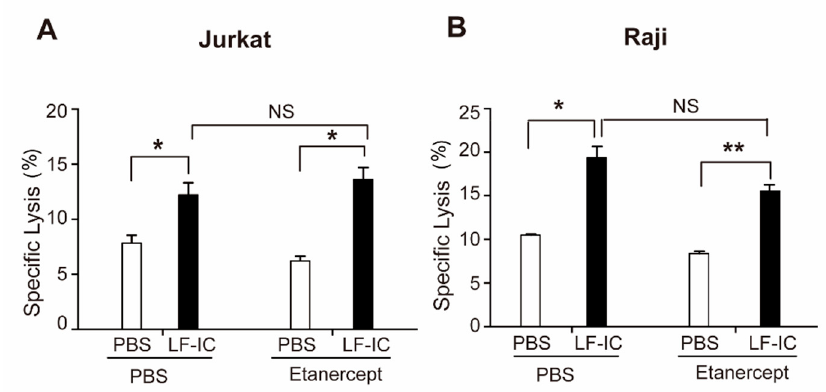
Figure 2. The tumoricidal function of LF-IC-primed human monocytes is independent of TNF α secretion. LF-IC primed monocytes were treated by 100 µ g / mL Etanercept or left untreated for 24 h. CFSE labeled Jurkat ( A ) or Raji ( B ) were then added and co-cultured with primed monocytes for 18 h. Cells were acquired and analyzed by FACS with PI staining. Results were expressed by the percentage of CFSE + PI + cell counts in CFSE + cell counts. * p < 0.05, ** p < 0.01.